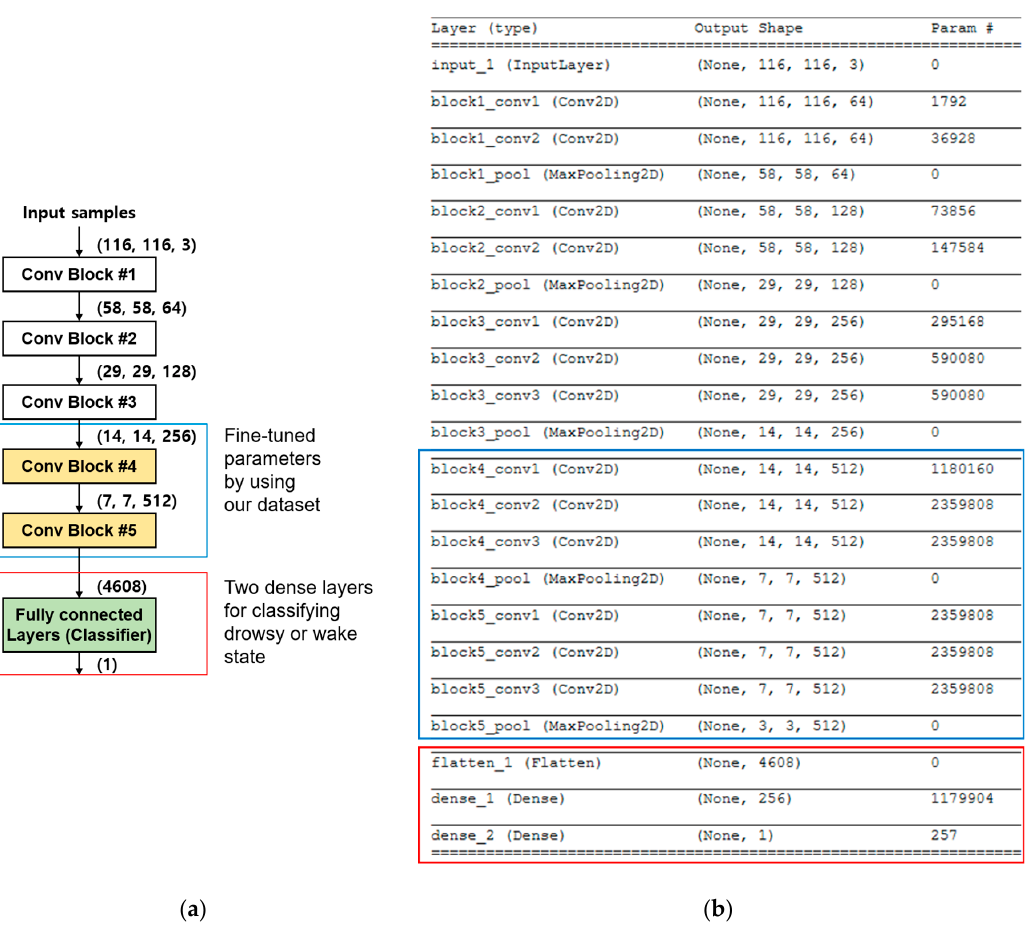
Figure 9. Architecture of our fine-tuned VGG16 convolutional neural network (CNN). Here, we used five convolution blocks and two fully connected layers for classification.